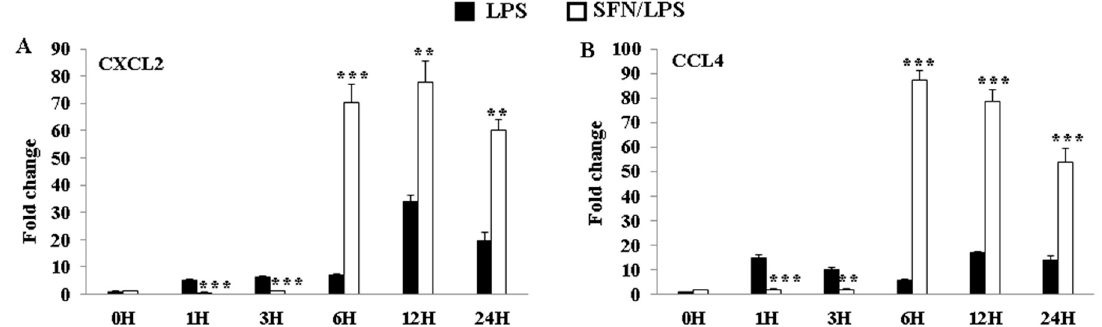
Figure 7. LPS-induced CXCL2 and CCL4 gene expression levels were dynamically regulated by SFN. The effects of SFN on mRNA expressions of CXCL2 ( A ) and CCL4 ( B ) in moDCs in response to LPS stimulation for 0, 1, 3, 6, 12, and 24 h were measured by qRT-PCR. The results were combined from three independent experiments and each experiment was performed in triplicate. The data are represented as the mean ± standard deviations (SD). ** p < 0.01; *** p < 0.001. Table 1. List of primer sequences used in this study.